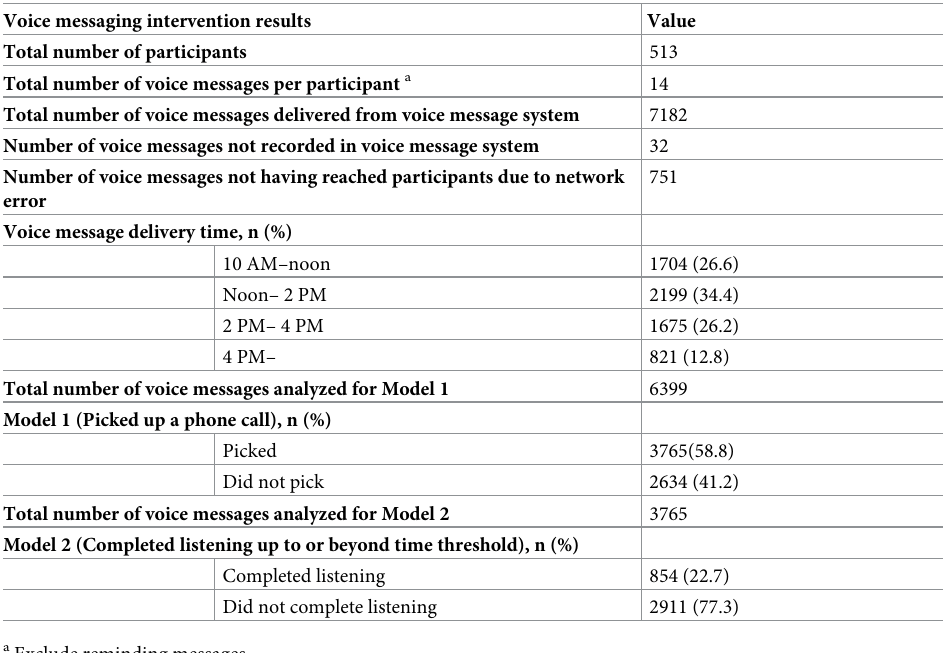
Table 3. Voice messaging intervention characteristics (n =